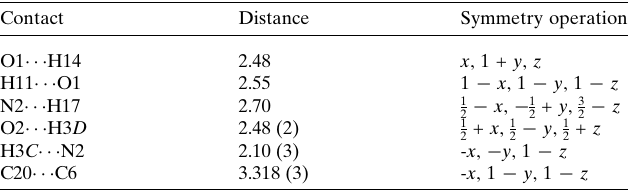
Table 2 Summary of short interatomic contacts (A˚ ) in the title compound. Contact Distance